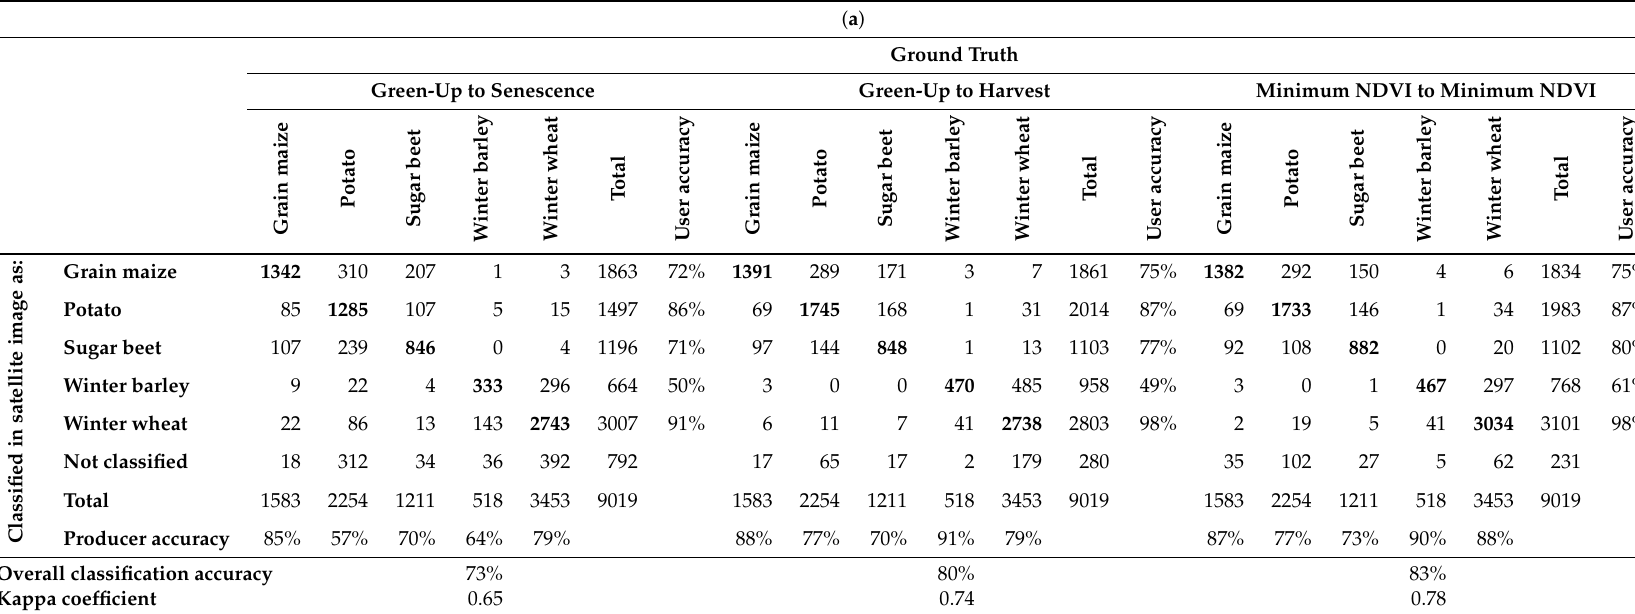
Table A1. Confusion matrix of classification analysis for green-up to senescence, green-up to dormancy and minimum NDVI at the beginning of the growing season to minimum NDVI at the end of the growing season assessment of Flanders-Belgium ( a ), Sria-Russia ( b ), Kyiv-Ukraine ( c ) and Sao Paulo-Brazil ( d ). The number of correctly-classified crops, the producer accuracy, the user accuracy, the overall accuracy and the kappa coefficient are